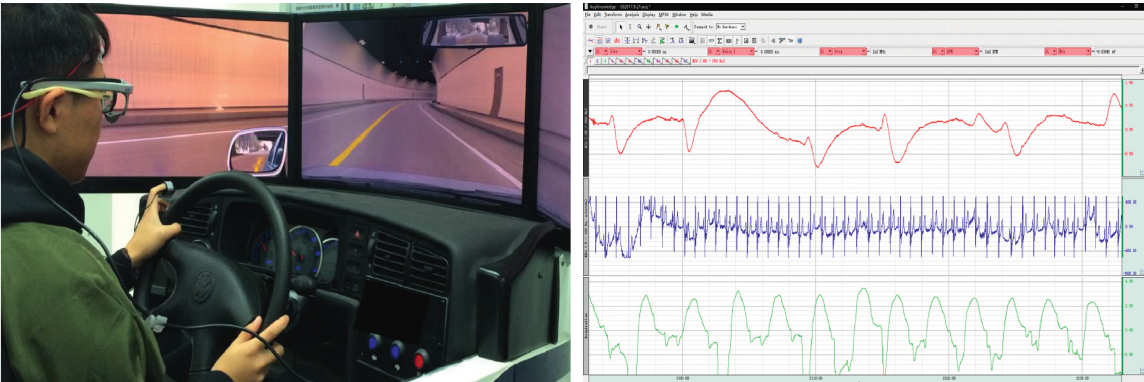
Figure 1: Main test equipment and data analysis interface.